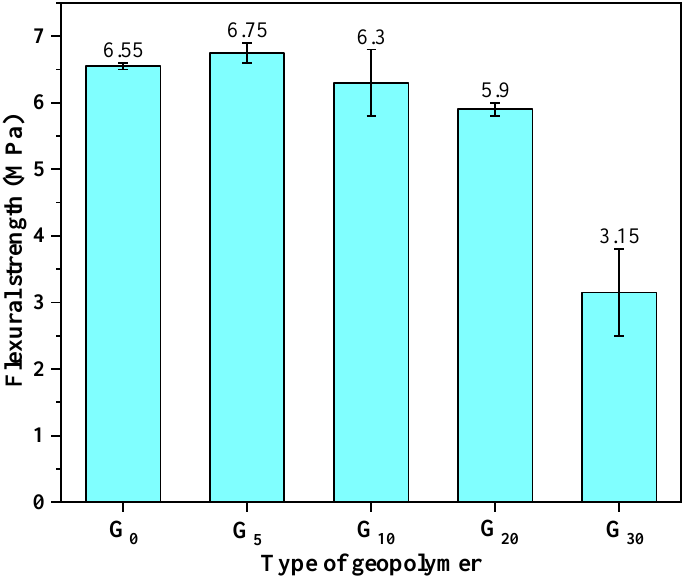
Figure 4. Flexural strength of geopolymers containing different proportions of CEM I.